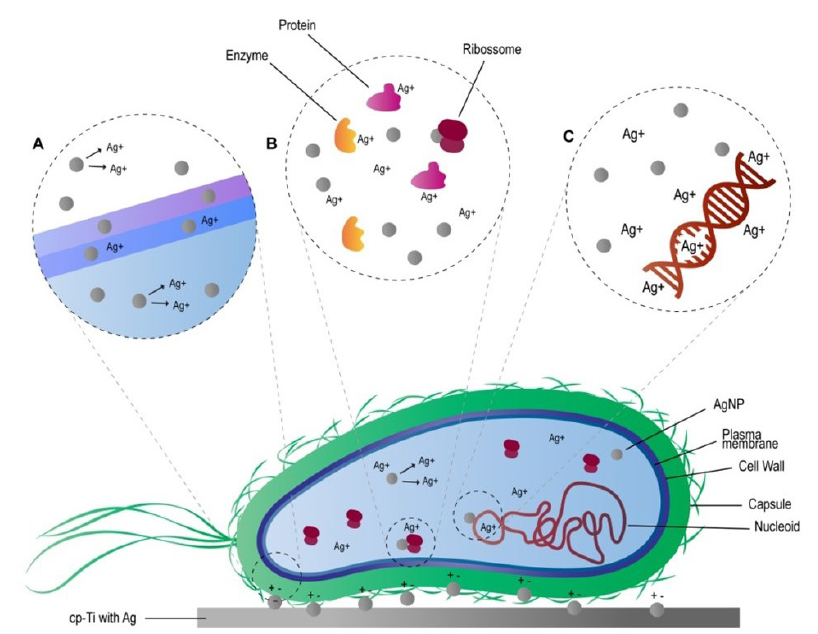
Figure 1. Hypothetical activity of silver in gram-negative bacteria (not to